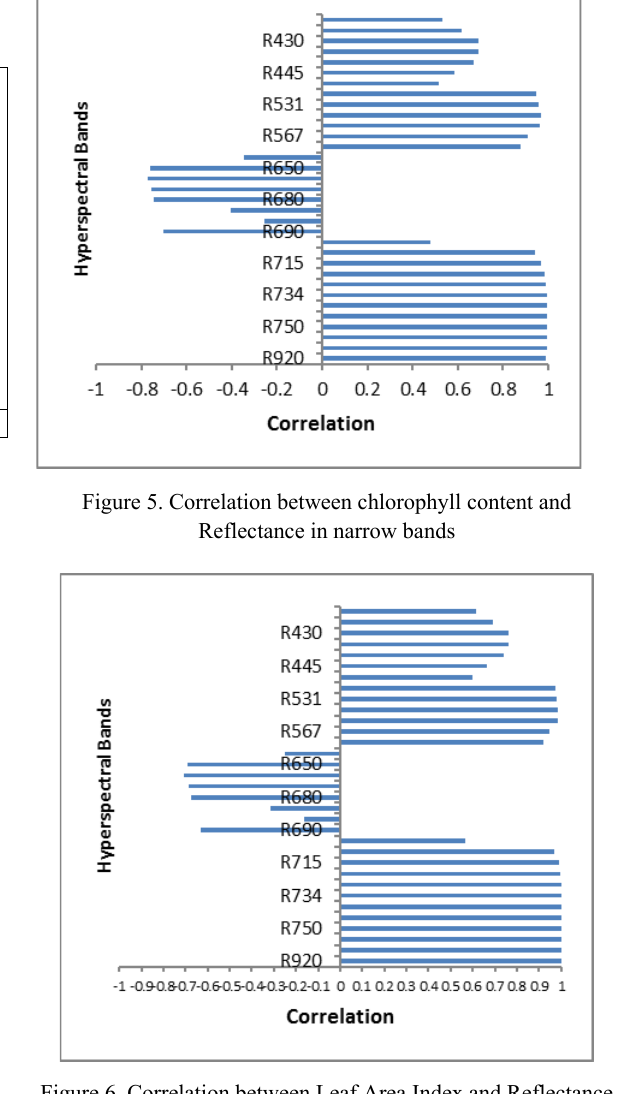
Figure 6. Correlation between Leaf Area Index and Reflectance in narrow bands Indices viz. Greenness index, Modified Chlorophyll Absorption in Reflectance Index (MCARI), Transformed Chlorophyll Absorption in Reflectance Index (TCARI), Triangular Vegetation Index (TVI), Simple Ratio Pigment Index (SRPI), Photochemical Reflectance Index (PRI 2), Lichtenthaler Indices Figure 4 Comparison between spectra of normal and diseased (LIC1, LIC2), Structure Intensive Pigment Index (SIPI) Brinjal in Baruipur, West Bengal